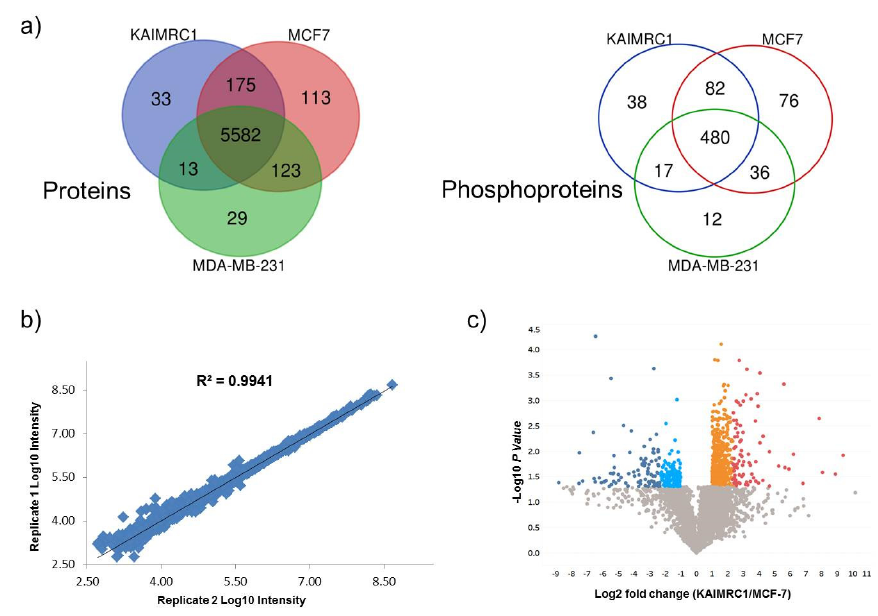
Figure 2. Quantitative proteomics analysis: ( a ) Venn diagram illustrated the overlap identified protein (left) and phosphoproteins (right) between KAIMRC1, MCF-7, and MDA-MB-231. ( b ) Reproducibility evaluation for duplicate biological replicates in MCF7 cell lines using proteins normalized intensities (Reproducibility evaluation of proteins and phosphoproteins for other cell lines can be found in supplementary Figures S2 and S3). ( c ) Volcano plot display differentially expressed proteins in KAIMRC Versus MCF7: Colored circles are significant proteins ( p < 0.05), and red is highly upregulated proteins with fold change ≥ 5. Upregulated protein is plotted in orange with fold change between 2 to 5. Light blue is downregulated protein with fold change ≤ 0.5. Dark blue is highly downregulated protein with fold change ≤ 0.2. Gray circles are nonsignificant proteins. (Volcano plots of differentially expressed proteins and phosphoproteins for the other pairwise comparisons showed in Supplementary Figures S4 and S5).